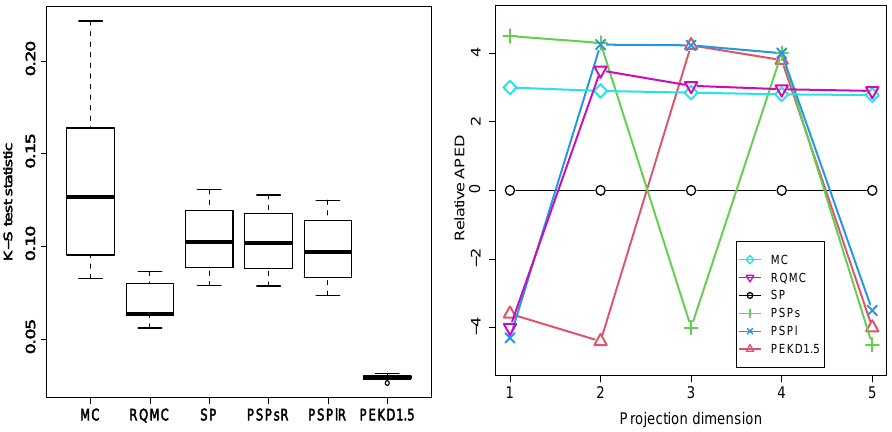
Figure 4. Box plots of K-S test statistic and relative average projected energy distance ( setting SP method as a benchmark by calculating sign ( APED k | )) APED k method